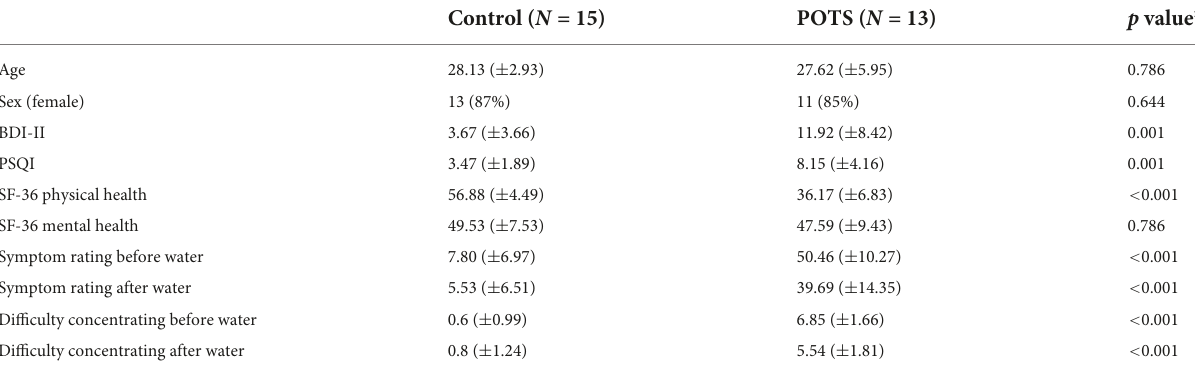
TABLE 1 Participant characteristics and symptoms during head-up tilt.